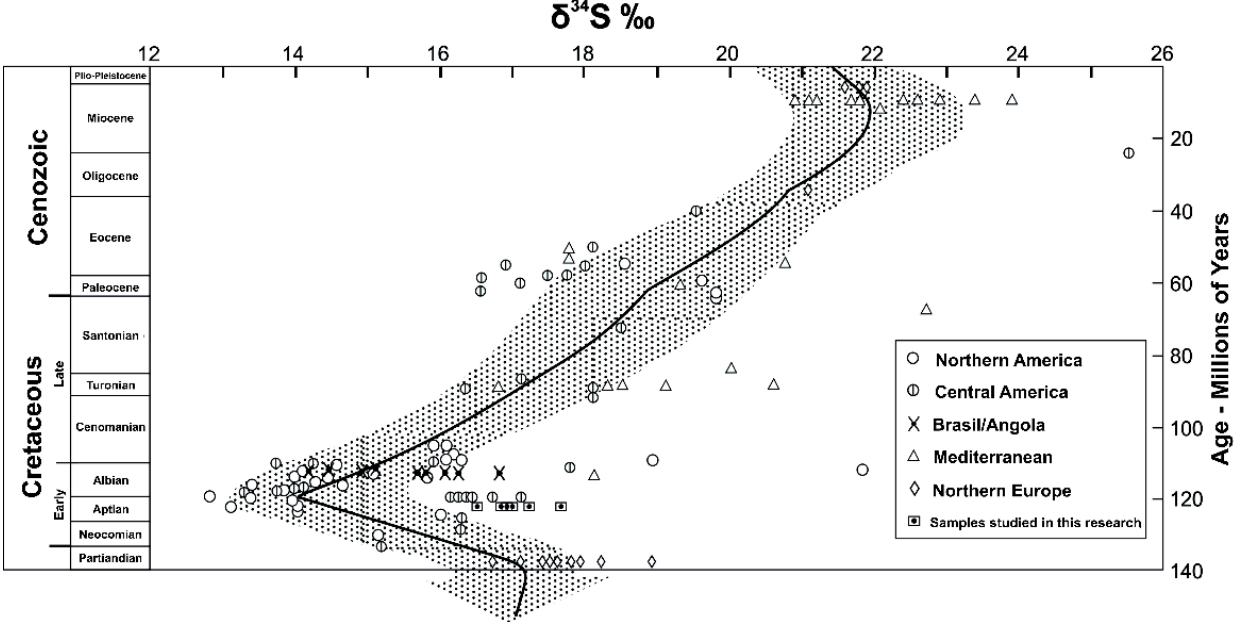
Figure 8. Global curve of sulfur isotopic variations in marine evaporites from the Cretaceous modified from Claypool (1980) [90]. Data from North America, Central America, Brazil/Angola (only from the coastal basins), Mediterranean, Northern Europe, and this research.